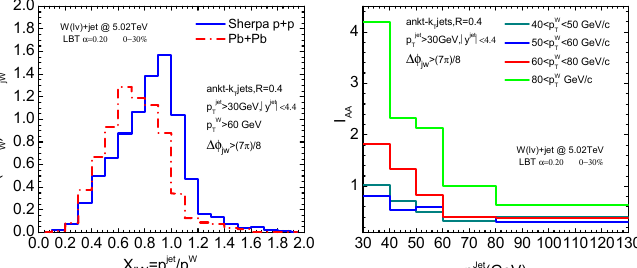
Figure 10. Left: the transverse momentum imbalance of W + jet in p + p and Pb + Pb at the LHC. Right: I AA of W + jet as a function of p jet at the T